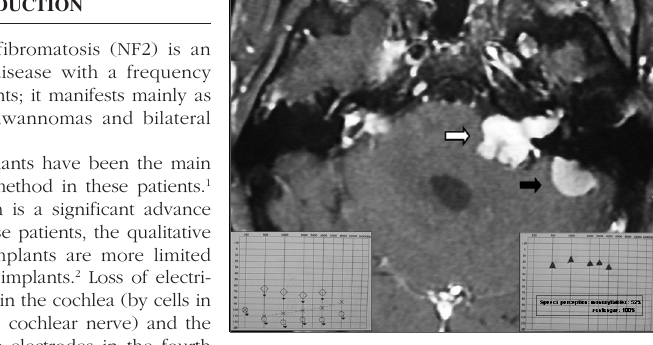
Figure 1. Magnetic resonance imaging (T1 contrast) showing a vestibular schwannoma to the left (white arrow) associated with a meningioma on the medial aspect of the left petrous bone (black arrow). Note also small manipulation remains in the right pontocerebellar angle. On the lower left detail, see preoperative audiometry. On the lower right detail see audiometry 6 months after the cochlear